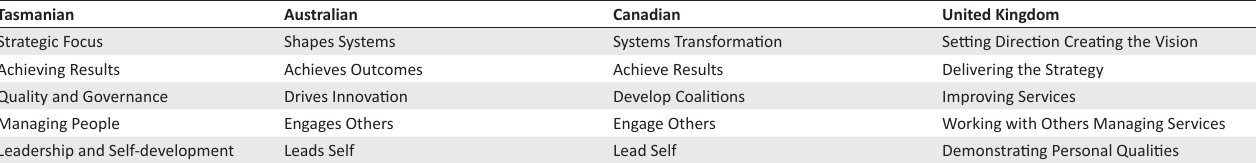
TABLE 1: Main components of health leadership frameworks compared.